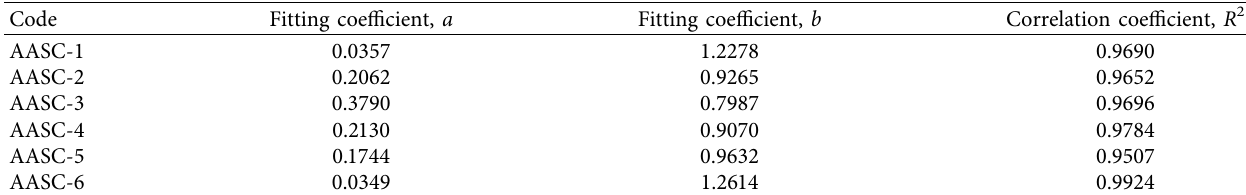
Table 10: Compressive strength accumulative damage power function and pertinence coefficient.